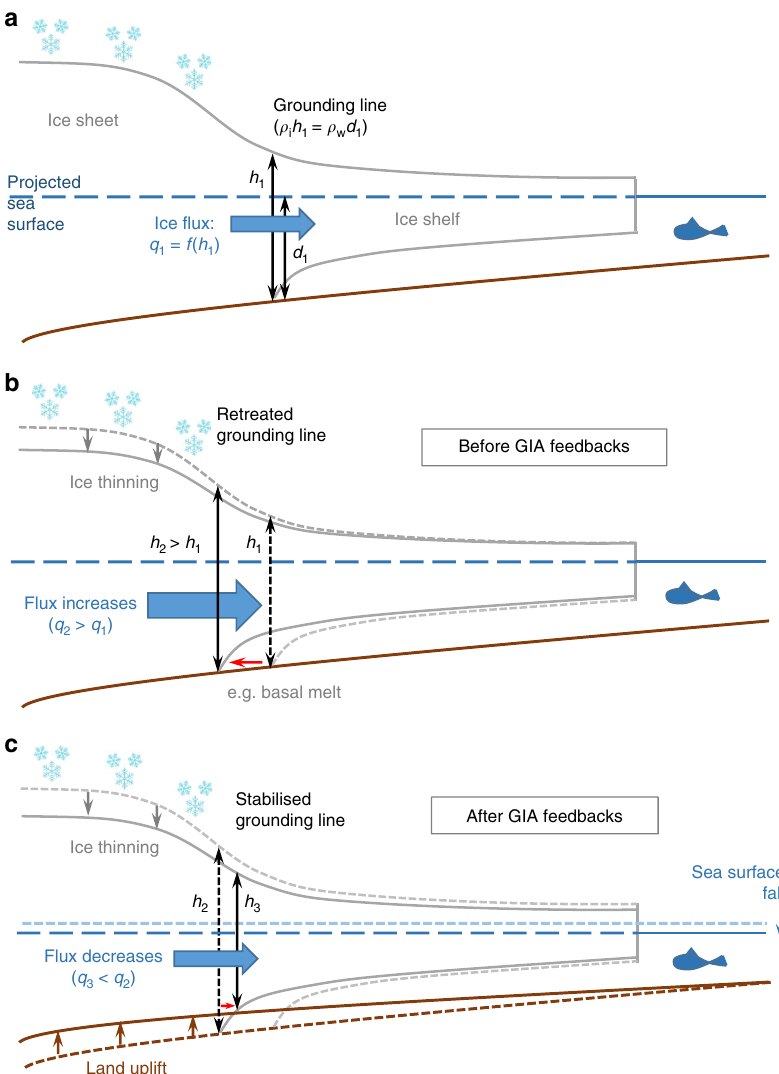
Fig. 5 Stabilising effect of GIA on ice dynamics. a The grounding line is the location where the ice sheet begins to fl oat. Flux across the grounding line ( q 1 ) depends on ice thickness at the grounding line ( h 1 ). The position of the grounding line also depends on water depth at the grounding line ( d 1 ), the density of ice ( ρ i ), and the density of seawater ( ρ w ). b Before GIA feedbacks: on a reverse bed slope grounding line retreats into deeper water (red arrow) due to, e.g., a reduction in ice shelf buttressing. Increase in ice thickness at the grounding line ( h 2 > h 1 ) results in an increase in ice fl ux across the grounding line ( q 2 > q 1 ). If ice input from upstream does not increase then the ice sheet thins, triggering further grounding line retreat. c After GIA feedbacks: following grounding line retreat, grounded ice loss triggers land uplift and sea surface lowering. The resulting decrease in water depth and hence ice thickness ( h 3 < h 2 ) at the grounding line results in a decrease in ice fl ux across the grounding line ( q 3 < q 2 ), which acts to stabilise the position of the grounding line. Initial con fi gurations shown by dashed lines, new con fi gurations shown by solid